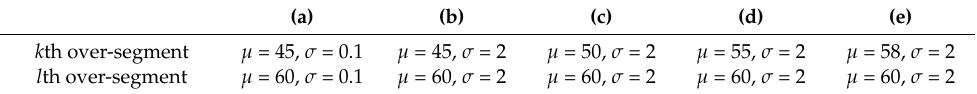
Table 1. Parameters of paired Gaussian distributions used in the five experiments.